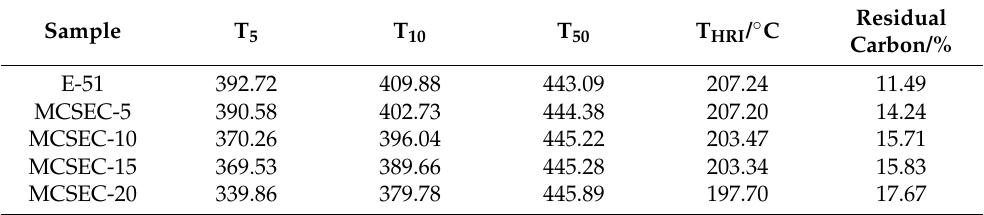
Table 1. Thermal stability data of pure epoxy resin and its